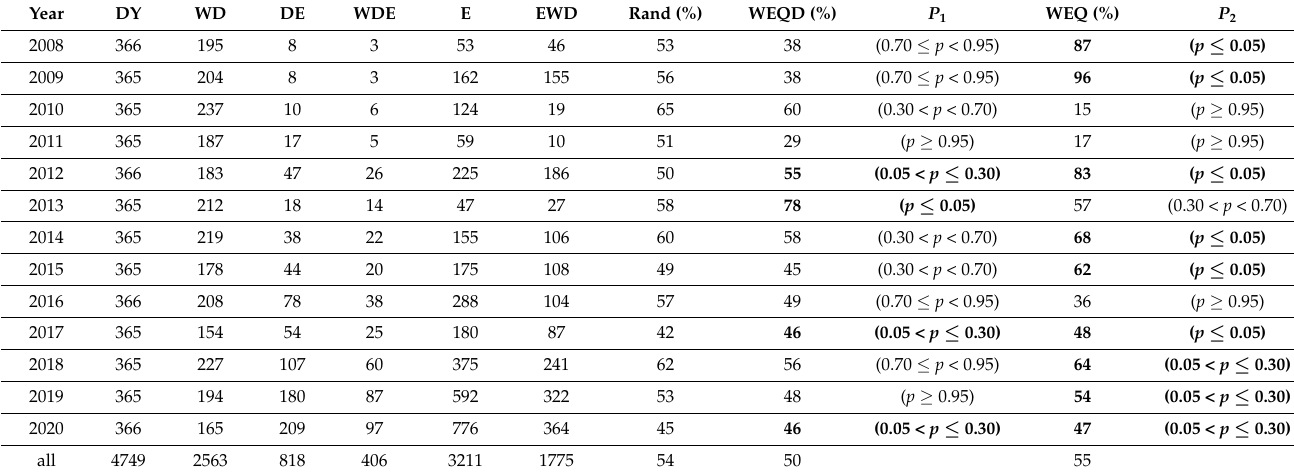
Table 1. Scenario #1, rain threshold R = 0.2 mm, memory τ = 1 day. The cases 0 < P ≤ 0.30 are highlighted in bold.